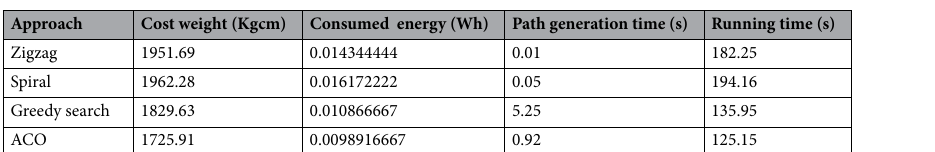
Table 5. The numerical comparisons for tested CWPP